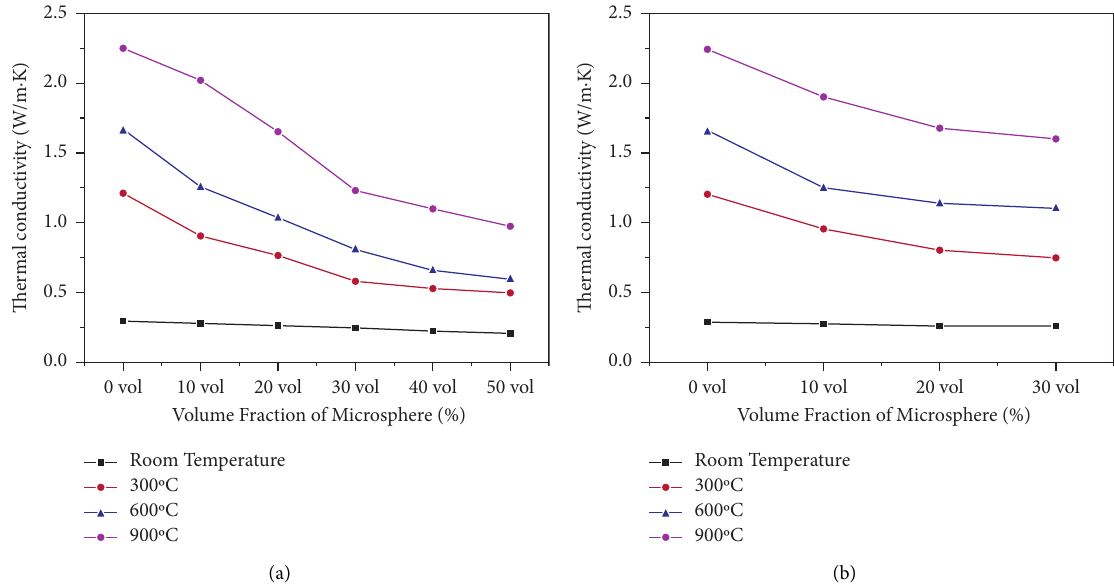
Figure 12: (a) The thermal conductivity of HGM/phenolic syntactic foam and (b) The thermal conductivity of HPM/phenolic syntactic